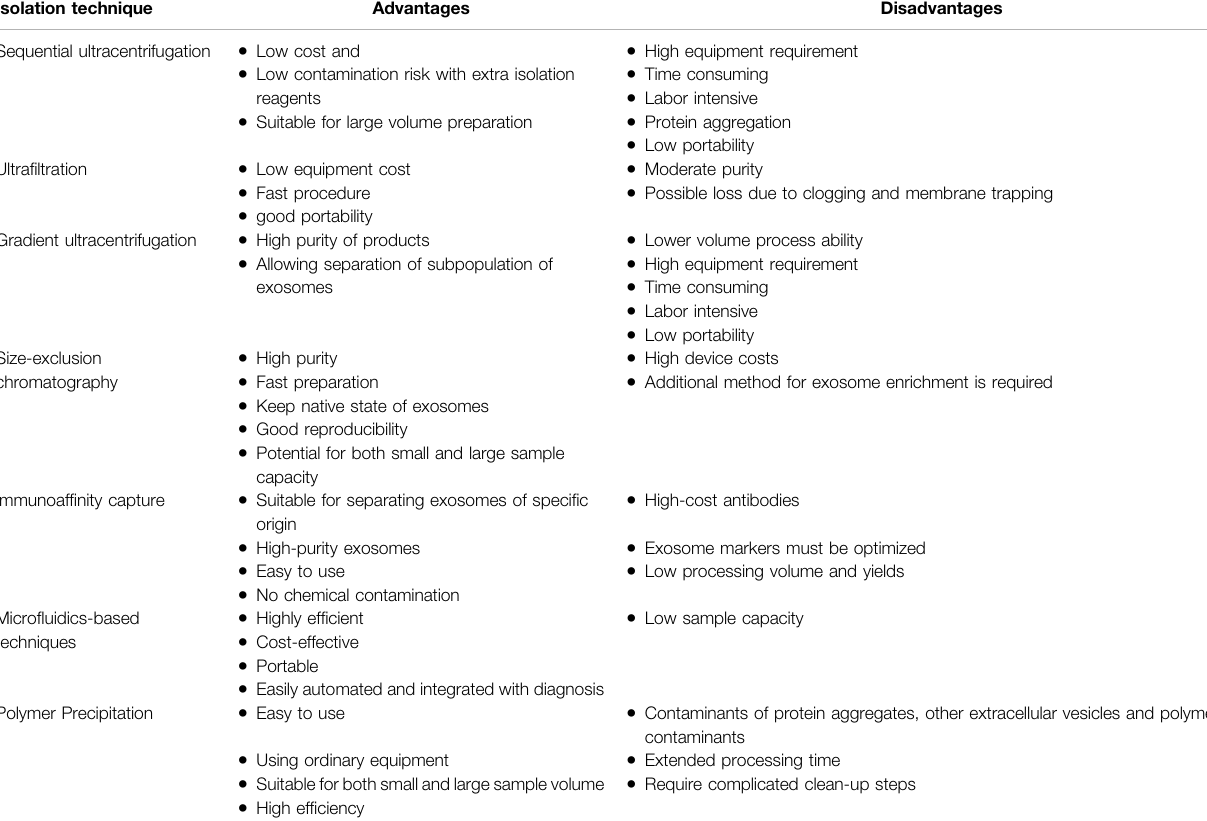
TABLE 1 | Current strategies for exosome separation (Yang et al., 2020). Isolation technique